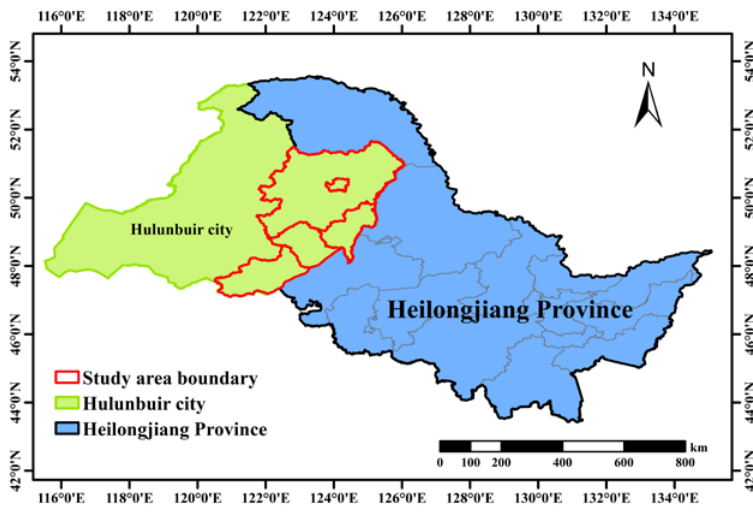
Figure 1. The geographical location of the study area. We surveyed plot crop types at 2292 coordinate points in the study area, but did not include plot boundary information, and we sampled within and at the boundaries of these plots, using the sampled pixel points to produce training samples. In total, we sampled 90,000 soybean pixels, 130,000 corn pixels, and 320,000 pixels of other background samples. The training samples were centered on the sampled pixel points and we expanded their 5 × 5 neighborhood windows as training patches, where only the central pixel was labeled and the other pixels within the window were unlabeled and used to provide spatial information and more spectral information to the central target pixel. The validation data were based on the surveyed plot types as well as manual visual interpretations, combined with the full pixel labels manually outlined by the images, which were used to validate the model’s accuracy. The distribution of the reference data sites is shown in Figure